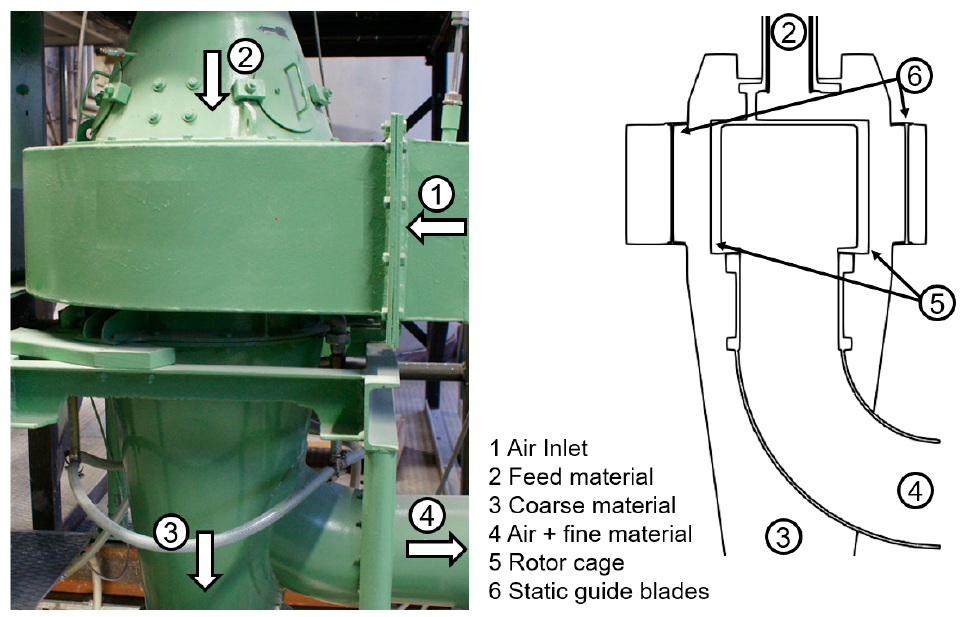
Figure 2. Schematic representation of the laboratory plant . Table 1. Characteristic sizes of material, air, and classifier wheel .